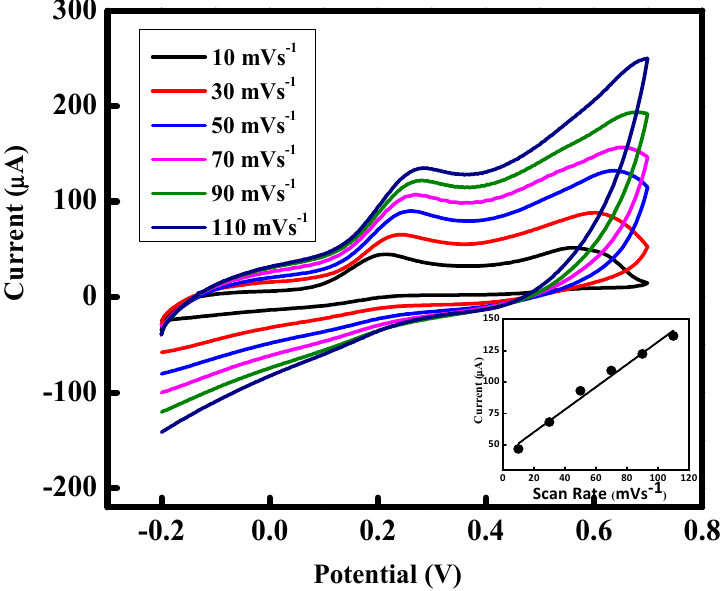
Figure 7. Cyclic voltammograms of the PANI modified electrode, in a solution of 4 mM AA in 0.1 M (pH = 4) phosphate buffer solution (PBS), at different scan rates (10 to 110 mV/s). 3.8. Effect of AA Concentration on Voltammetric Response of the PANI Modified Electrode The electrochemical behavior of bare Au disc and PANI modified electrode towards 4 mM AA in 0.1 M PBS (pH = 4) was investigated by recording cyclic voltammograms (CVs) in the potential range − 1 of − 0.2-0.7 V at 50 mVs (Figure 8a). The PANI modified electrode shows a high response towards AA oxidation compared to the bare electrode. It is also evident that oxidation of AA occurs at around 0.26 V on the PANI modified electrode while on the bare gold electrode this value is around 0.4